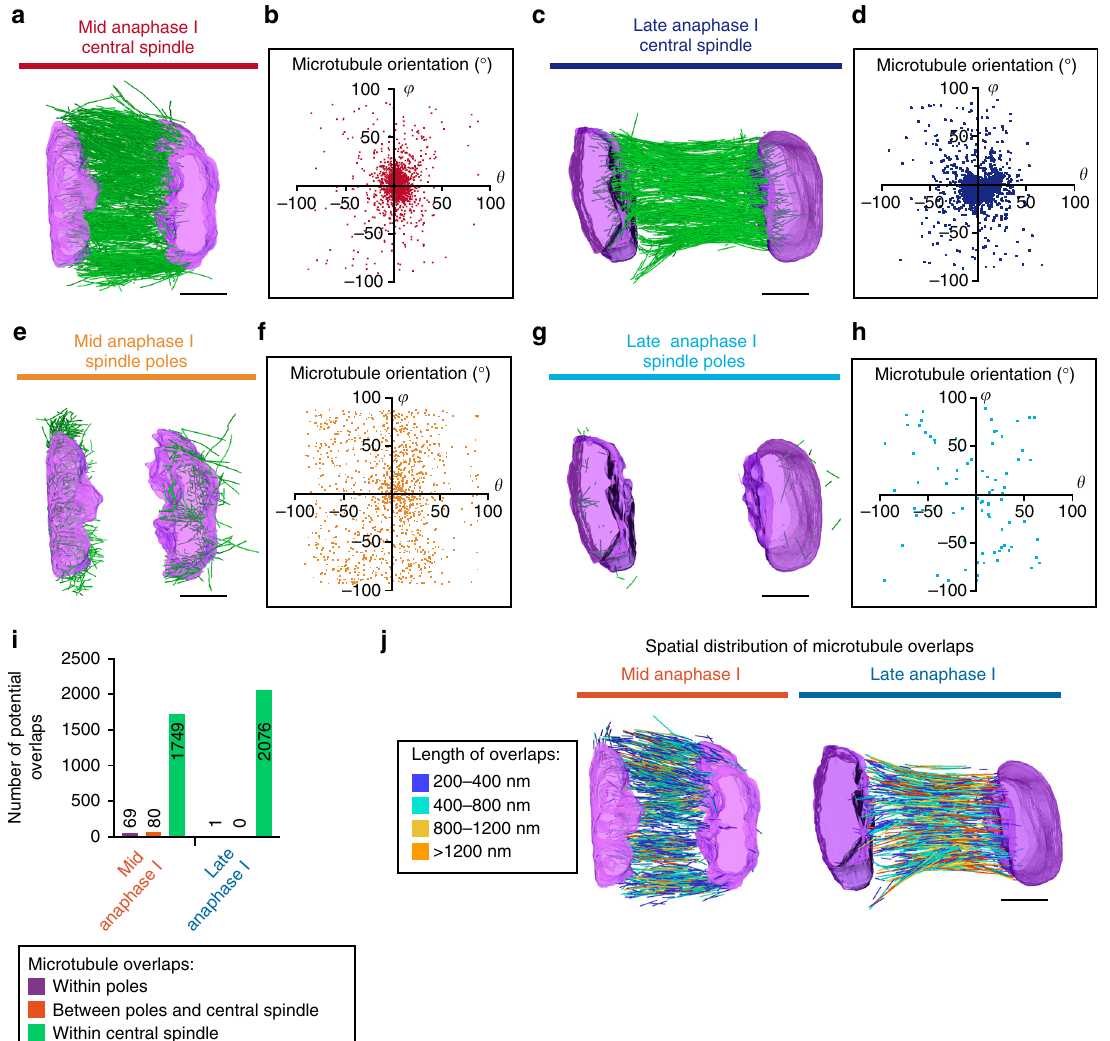
Fig. 2 Meiotic spindle poles are comprised of randomly organized short microtubules. a , c Central spindle microtubule population in the mid- a or late c anaphase I reconstructions. b , d Distribution of microtubule inclination ( θ ) and azimuthal ( φ ) angles for the mid- b or late d anaphase I central spindle microtubules. e , g Spindle pole microtubule population in the mid- e or late g anaphase I reconstructions. f , h Distribution of microtubule inclination ( θ ) and azimuthal ( φ ) angles for the mid- f or late h anaphase I spindle pole microtubules. i Quanti fi cation of microtubule overlaps > 200 nm in length for the indicated populations. j Visualization of the spatial distribution of microtubule overlaps > 200 nm in length in mid- and late anaphase I spindles. The length of overlaps is color-coded as indicated. Scale bars, 1 µ